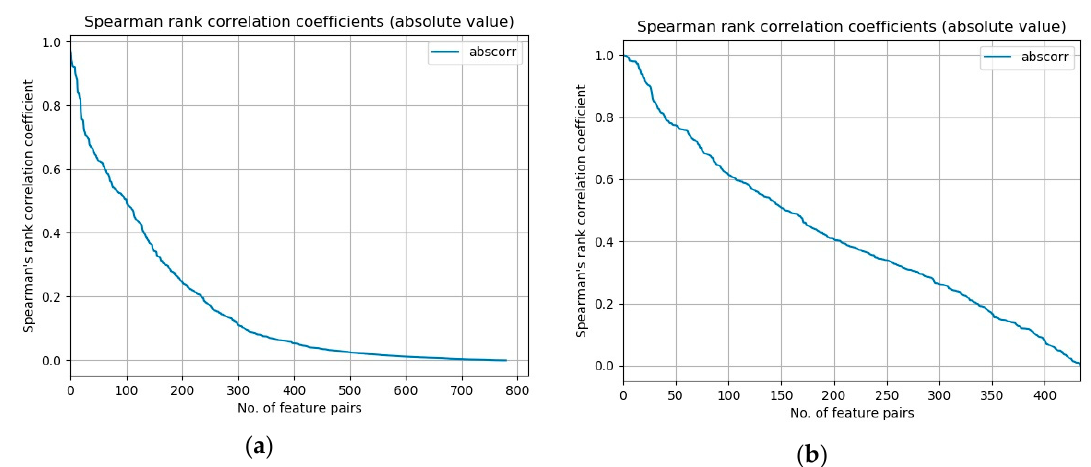
Figure 2. Absolute values of Spearman’s rank correlation coefficients of all distinct feature pairs, ordered by their value in descending order: ( a ) from the Network Security Laboratory of University of New Brunswick, Canada (NSL-KDD) dataset; ( b ) from the UCI Breast Cancer Wisconsin Dataset (UCI-BCW) dataset.